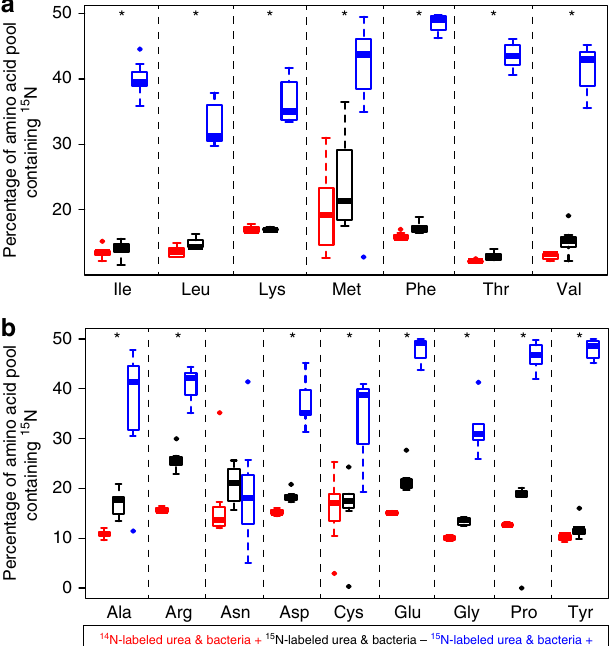
Fig. 2 Symbiont suppression reduces proportions of 15 N-labeled amino acids in hemolymph of Cephalotes varians workers consuming 15 N-labeled urea. a Essential and b non-essential amino acids in ant hemolymph measured through GC – MS. Asterisks indicate that 15 N in essential amino acids from ants consuming 15 N-labeled urea (blue) was signi fi cantly higher than that in antibiotic-treated ants on this same diet (black) and in those consuming diets with unlabeled urea (red). Details on sample sizes for each treatment can be found in Supplementary Data 6. Note that each separate box plot graphs the median (center line), the interquartile range (i.e., from the top to the bottom of each box), values equal to 1.5 times the interquartile range (tops and bottoms of whiskers), and outliers. Amino acids for which we observed signi fi cantly higher heavy isotope signal in the no antibiotic (blue) versus antibiotic (black) treatments, on the heavy isotope diet, are indicated with an asterisk. Statistics are described in the Supplementary Methods and Supplementary Table 3. In short, asterisks reveal results from Tukey ’ s post hoc tests (for normally distributed data after logit transformation) or Wilcoxon rank sum tests (for non-normal data after logit